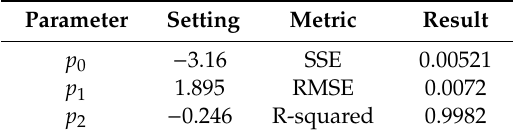
Table 4. Parameter settings and metrics of the normal surface.